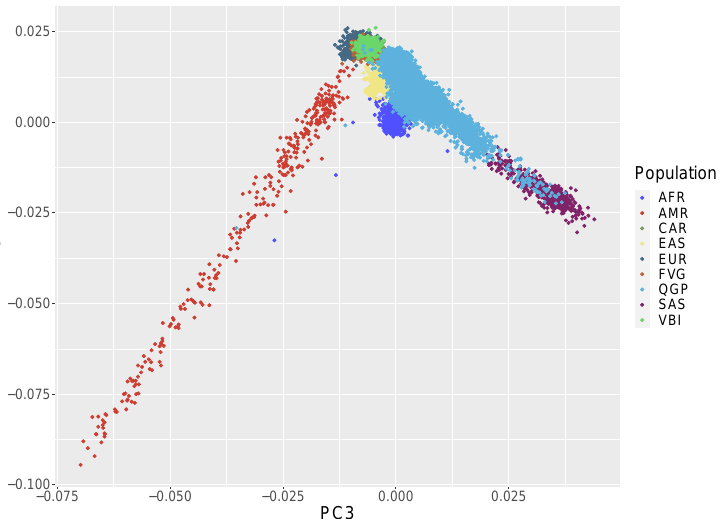
Figure 2. Distributions of the prioritization scores. Violin plots of the distributions of DSC (top panel) and SSC (bottom panel) scores in the subset of selected genes for all target populations (CAR, FVG, VBI, QGP) and all reference outbred populations (AFR, EUR, SAS) from 1000Genomes